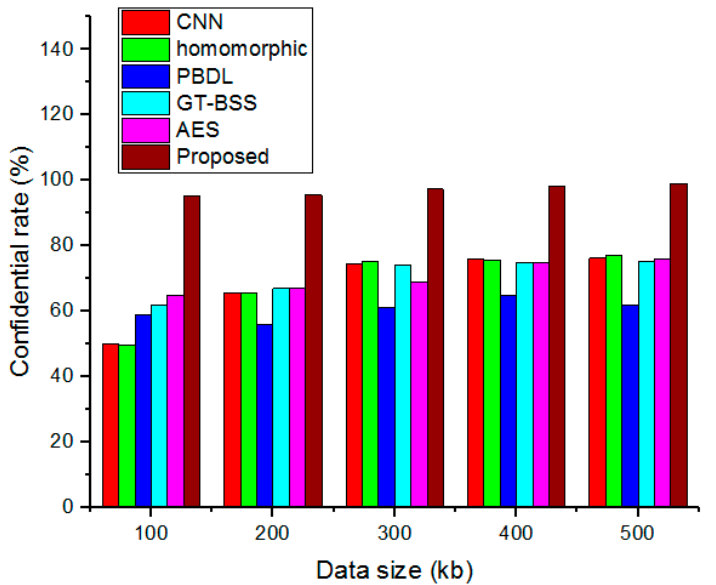
Figure 9. Performance analysis of the confidential rate.